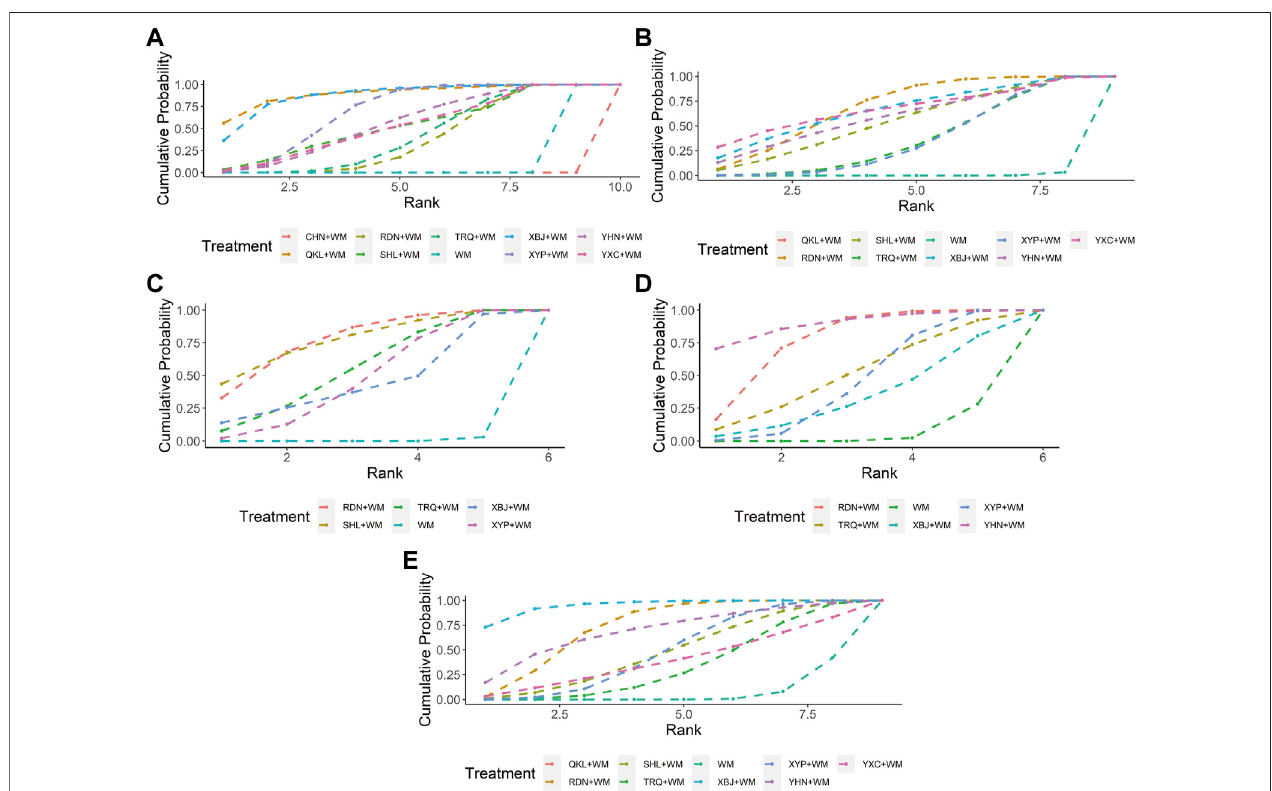
FIGURE3 | Plots ofthe surface under thecumulative ranking curves for all interventions (A) Clinical effectivenessrate (B) Antipyretic time (C) Sore throat relief time (D) Red and swollen tonsils relief time (E) Tonsillar exudate relief time; WM, Western Medicine; RDN, Reduning injection; TRQ, Tanreqing injection; QKL, Qingkailing injection; XBJ, Xuebijing injection; SHL, Shuanghuanglian injection; YHN, Yanhuning injection; CHN, Chuanhuning injection; YXC, Yuxingcao injection; XYP, Xiyanping